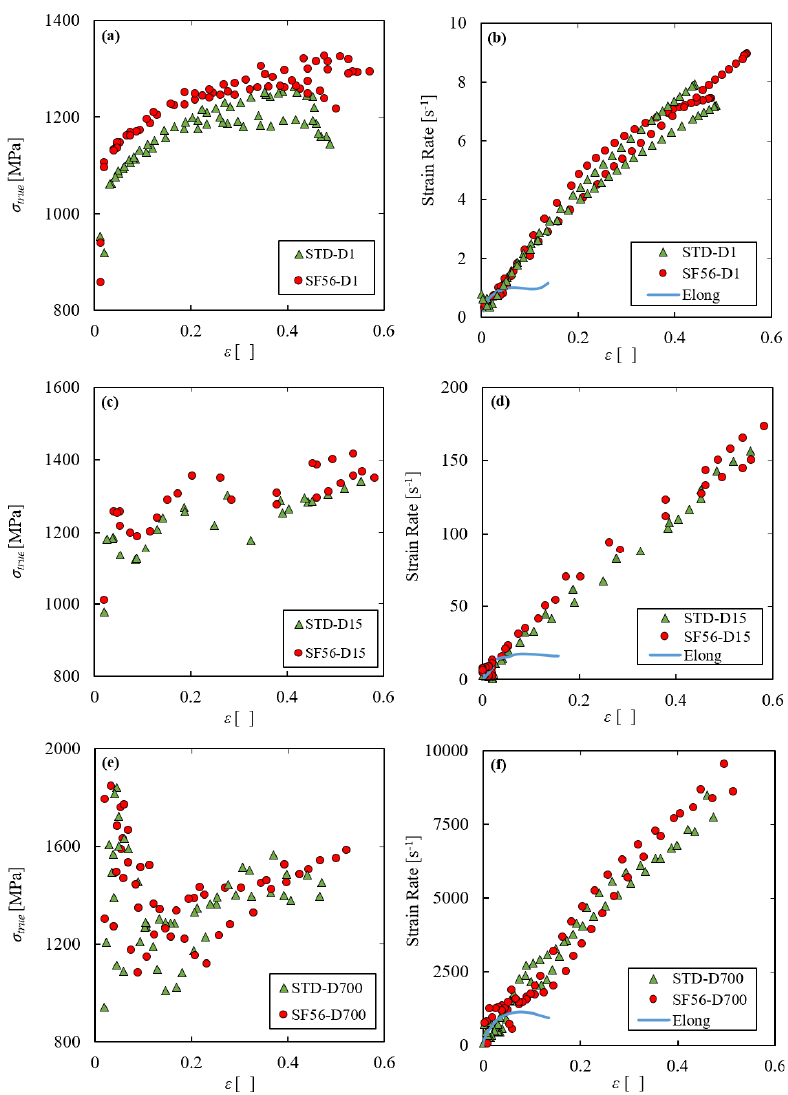
Figure 6. Comparison between the tensile behaviors obtained with the standard and SF56 parameter sets in terms of true stress–strain curves and strain rate vs. strain curves at 1 s − 1 ( a , b ), 15 s − 1 ( c , d ) and 700 s − 1 ( e , f ).